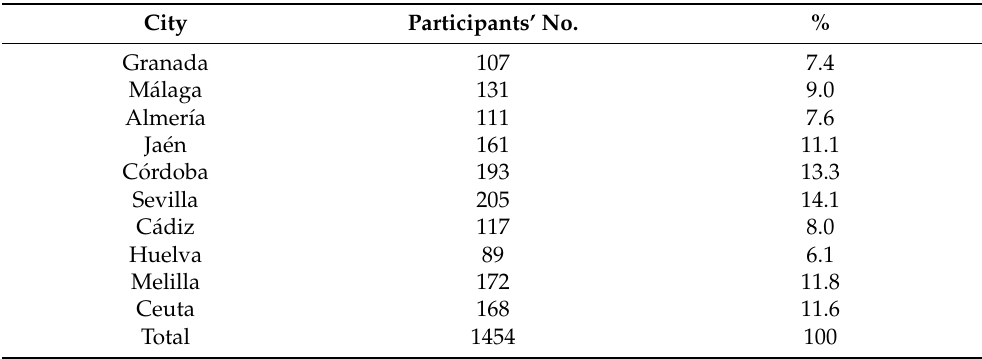
Table 1. Distribution of participants by